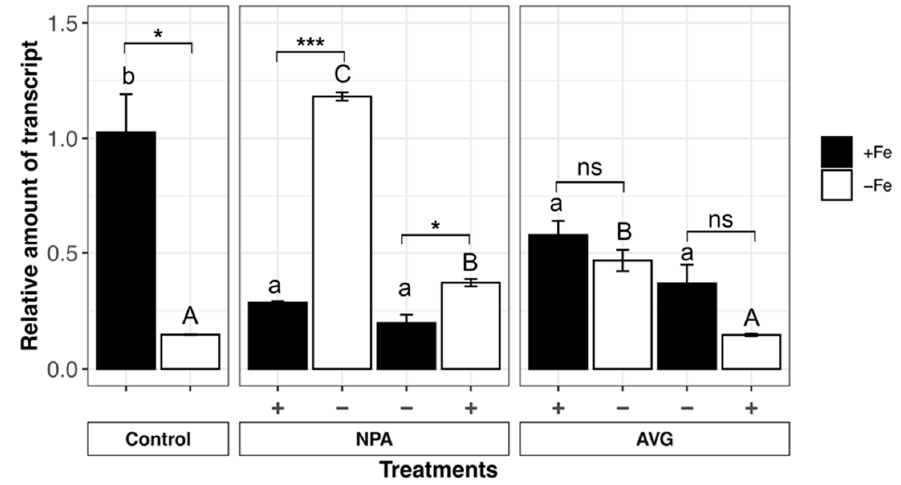
Figure 5. Quantitative real time RT-PCR analyses of SlFRO1 expression in roots: the expression levels of SlFRO1 was assessed by qRT-PCR. The data were normalized to the internal control Tomato LeEF-1 mRNA for elongation factor 1 alpha . The relative expression ratios were calculated using resupplied roots as a calibrator sample. Data are reported as means ± SE of three independent biological replicates (each biological replicate was the mean of five plants) for each treatment. Statistical significance was tested by one-way ANOVA analysis with Tukey post hoc tests ( p < 0.001). Di ff erent letters indicate statistically di ff erent values. The statistical significance between resupplied and not-resupplied root compartments was tested by Student’s t -test (*, p < 0.05; ***, p <